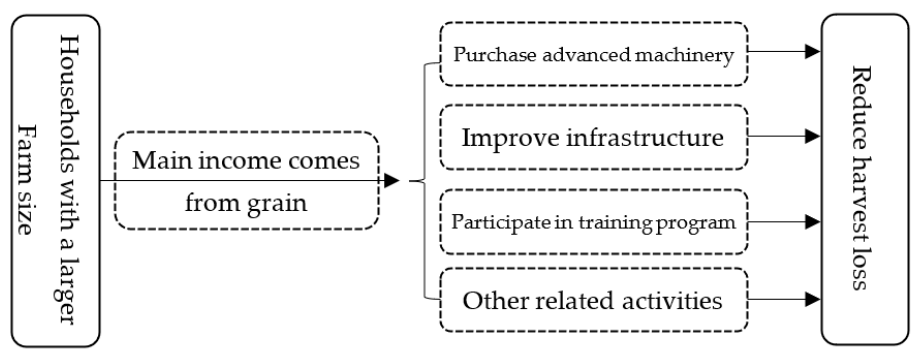
Figure 4. Model of the mechanism by which farm size impacts harvest losses.